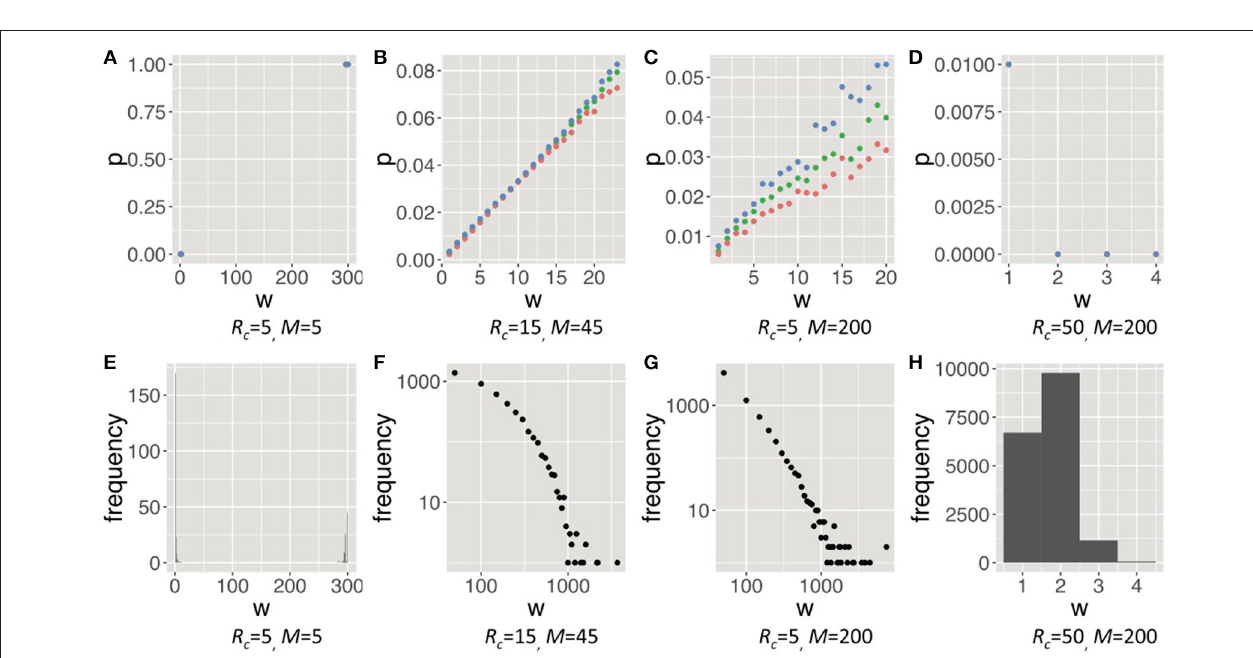
FIGURE 5 | Average selection pressures ( ds , dq ) in four trends for ( s , q ) and typical orbits from ( s , q ) = (0,0.5) ( R g = 300). These figures show trends 1, 2, 3, and 4 from left. The cell colors show the gradients of s and q (i.e., ds , dq ). For example, the figures show s and q decrease when ( s , q ) is in a cell of ds < 0 and dq < 0. Areas, where the cell colors are mixed, show little gradients, that is, mutation noises were larger than selection pressures. For example, populations were random walk along the s axis and they were small along the q axis, when s < − 1 in R c = 5 and M = 200. Evolutionary dynamics in R g = 100 showed similar trends (see Figure S3).